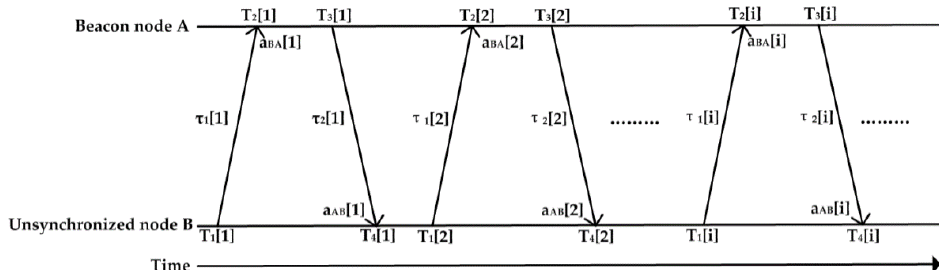
Figure 1. DE-Sync Message Exchange Scheme.